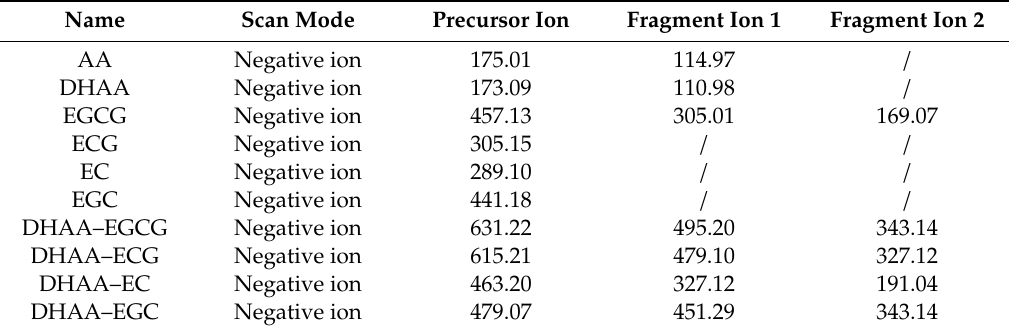
Table 1. Precursor ion and characteristic fragment ion of substrates and new